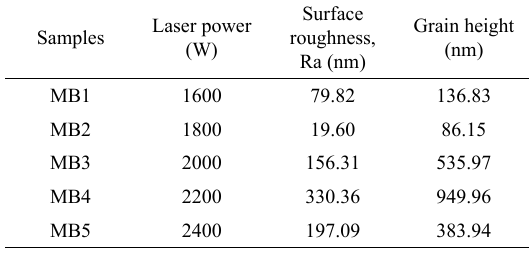
Table 5. Surface roughness of laser deposited samples. Samples